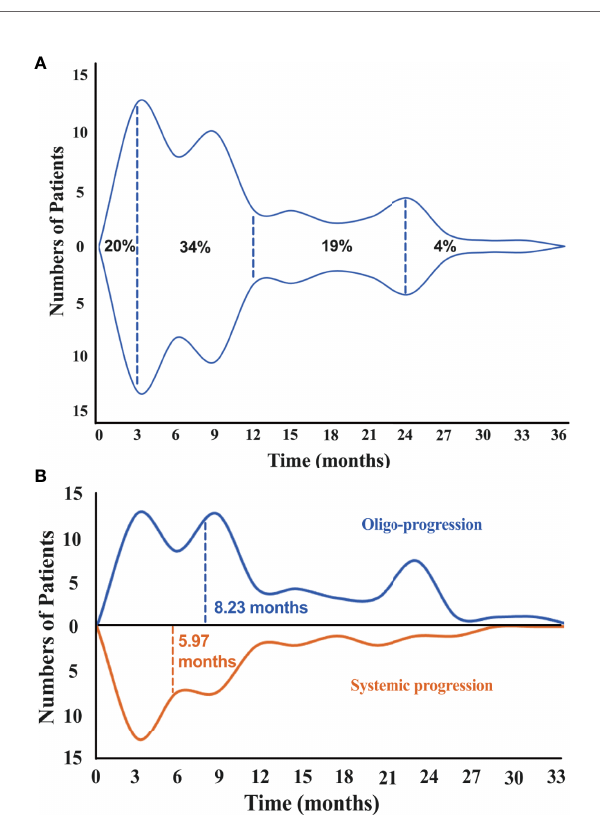
(B) Median time of disease progression among patients with oligo- progression (above midline) and systemic progression (below midline).